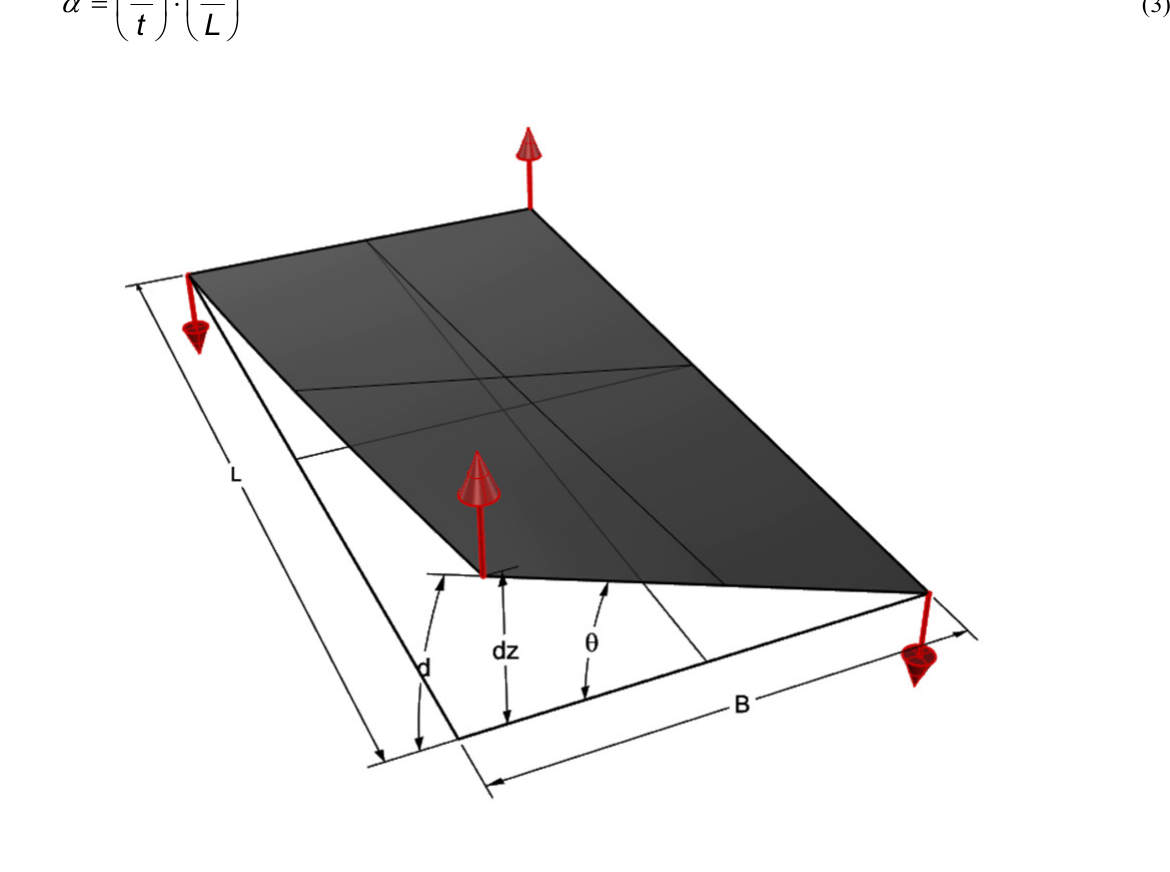
Fig. 3 Twist Angle, Corner Displacement, and Arc